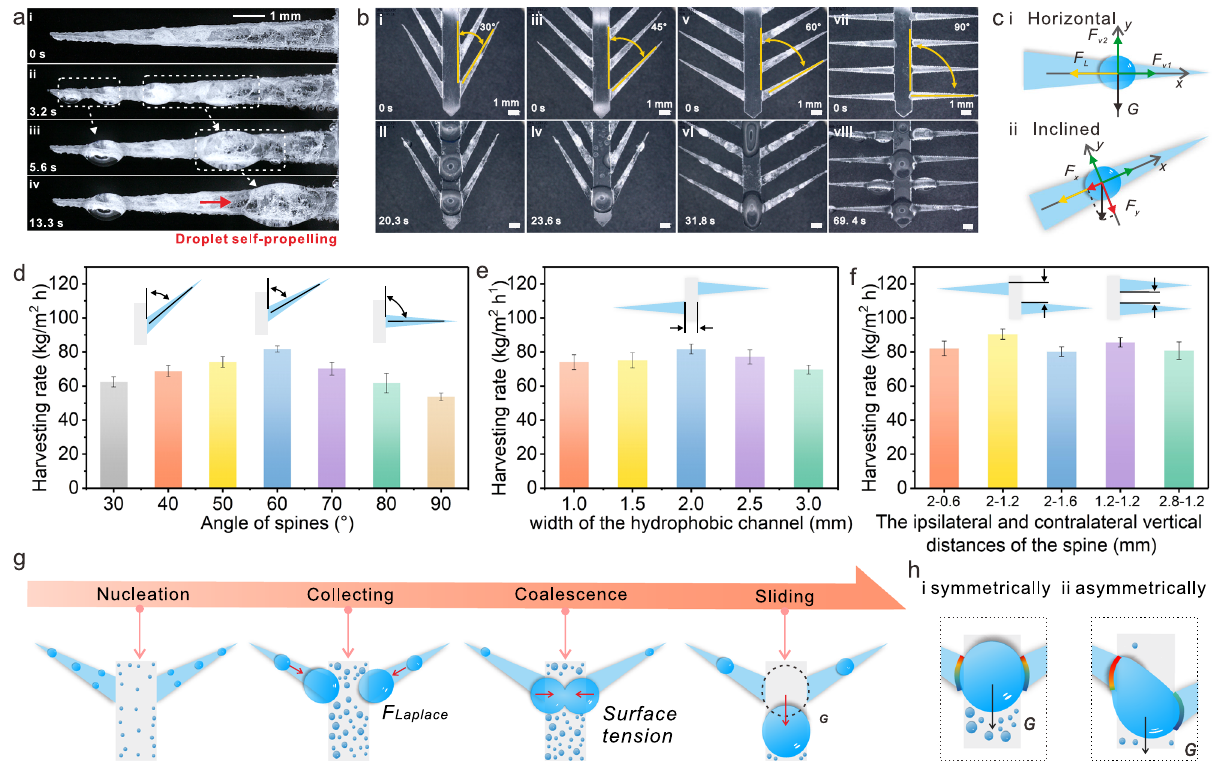
Fig. 4 Water-harvesting performance of dual bionic structures. a The harvesting process of the fog on the ACEC@FEP spine. b Fog harvesting in an array with different angles between the spine and hydrophobic channel (30, 45, 60, and 90°). c Force analysis of the droplets on different spines. d Water- harvesting rate of the array with different angles. e , f Water-harvesting rate of the array with different hydrophobic channel widths and different vertical distances of the spines; the root width of the spine is 1.2 mm. g Schematic diagram of the water harvesting. h The force analysis of the droplets on the array with symmetric and asymmetric